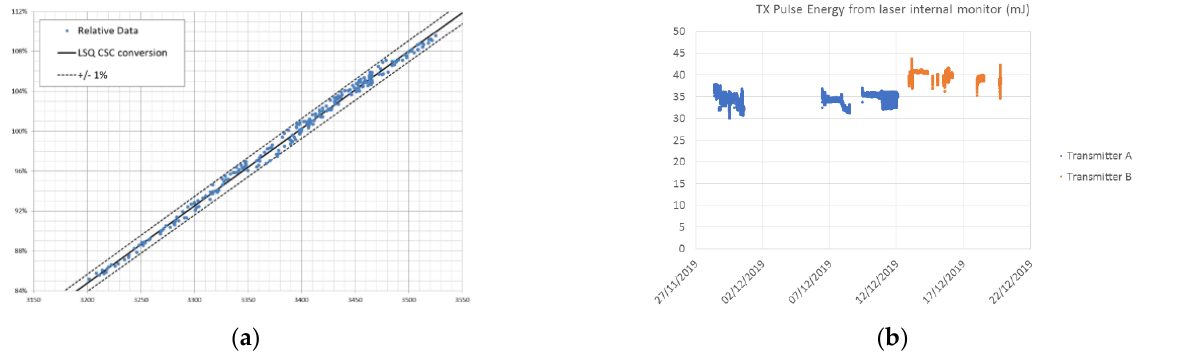
Figure 8. Example of Energy measurements performed during TVAC via the internal laser photodiode: ( a ) Energy telemetry calibration plotting calibrated detector measurement of emitter energy (y) against internal laser photodiode (x); ( b ) Overview of Energy measurements during the entire vacuum phase (mJ).